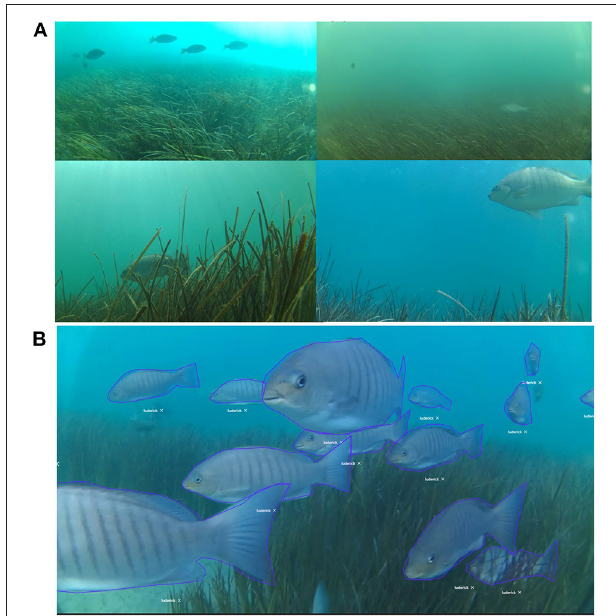
FIGURE 1 | (A) Example images of free swimming fish (luderick) in uncontrained seagrass habitats. This dataset provides footage from different angles, from cameras exposed to different environmental conditions such as tide, lighting, water clarity, color hue experienced under real-world conditions. (B) Segmentation masks around luderick allow for this dataset to be used for a number of computer vision